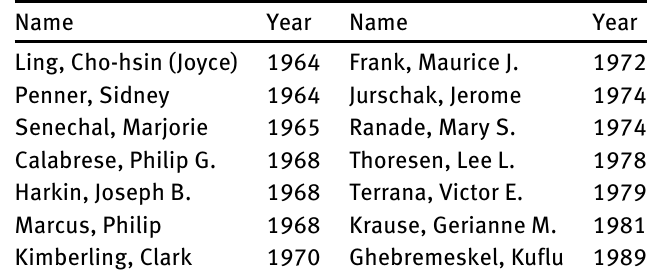
Table 1: A list of Abe Sklar’s 14 PhD students at the Illinois Institute of